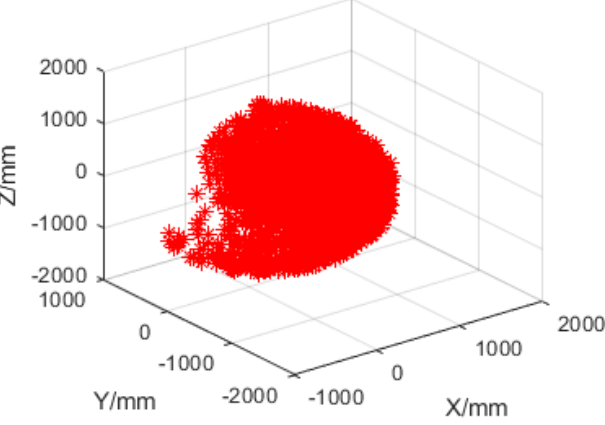
Figure A2. The workspace of the end effector of the humanoid manipulator.